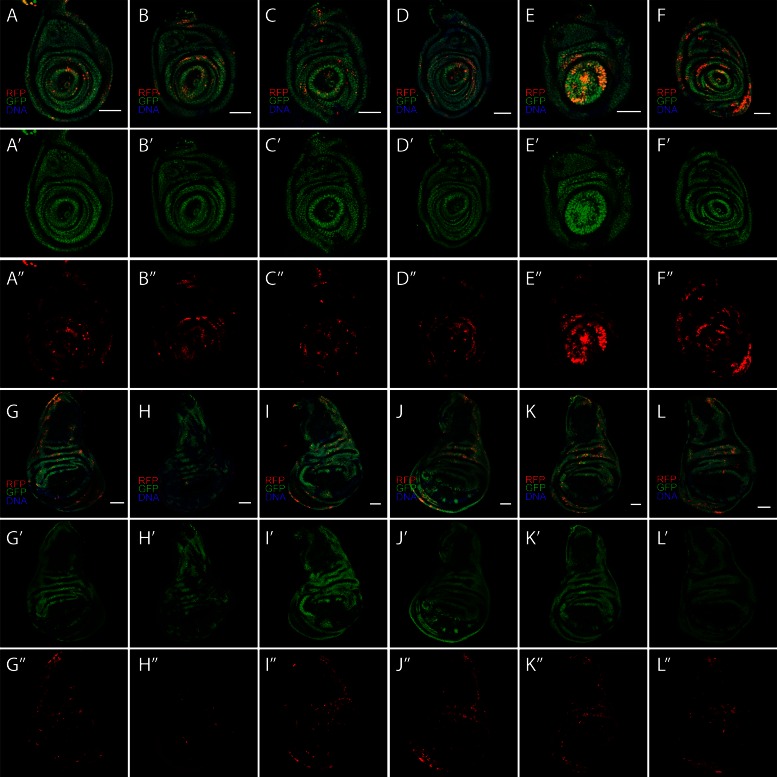
Diverse CasExpress patterns in leg and wing discs.Six different examples of RFP and GFP expression patterns in leg (A–F) and wing (G–L) discs of late 3rd instar larvae. (A’–L’) GFP only. (A”–L”) RFP only. All scale bars are 50 μm.